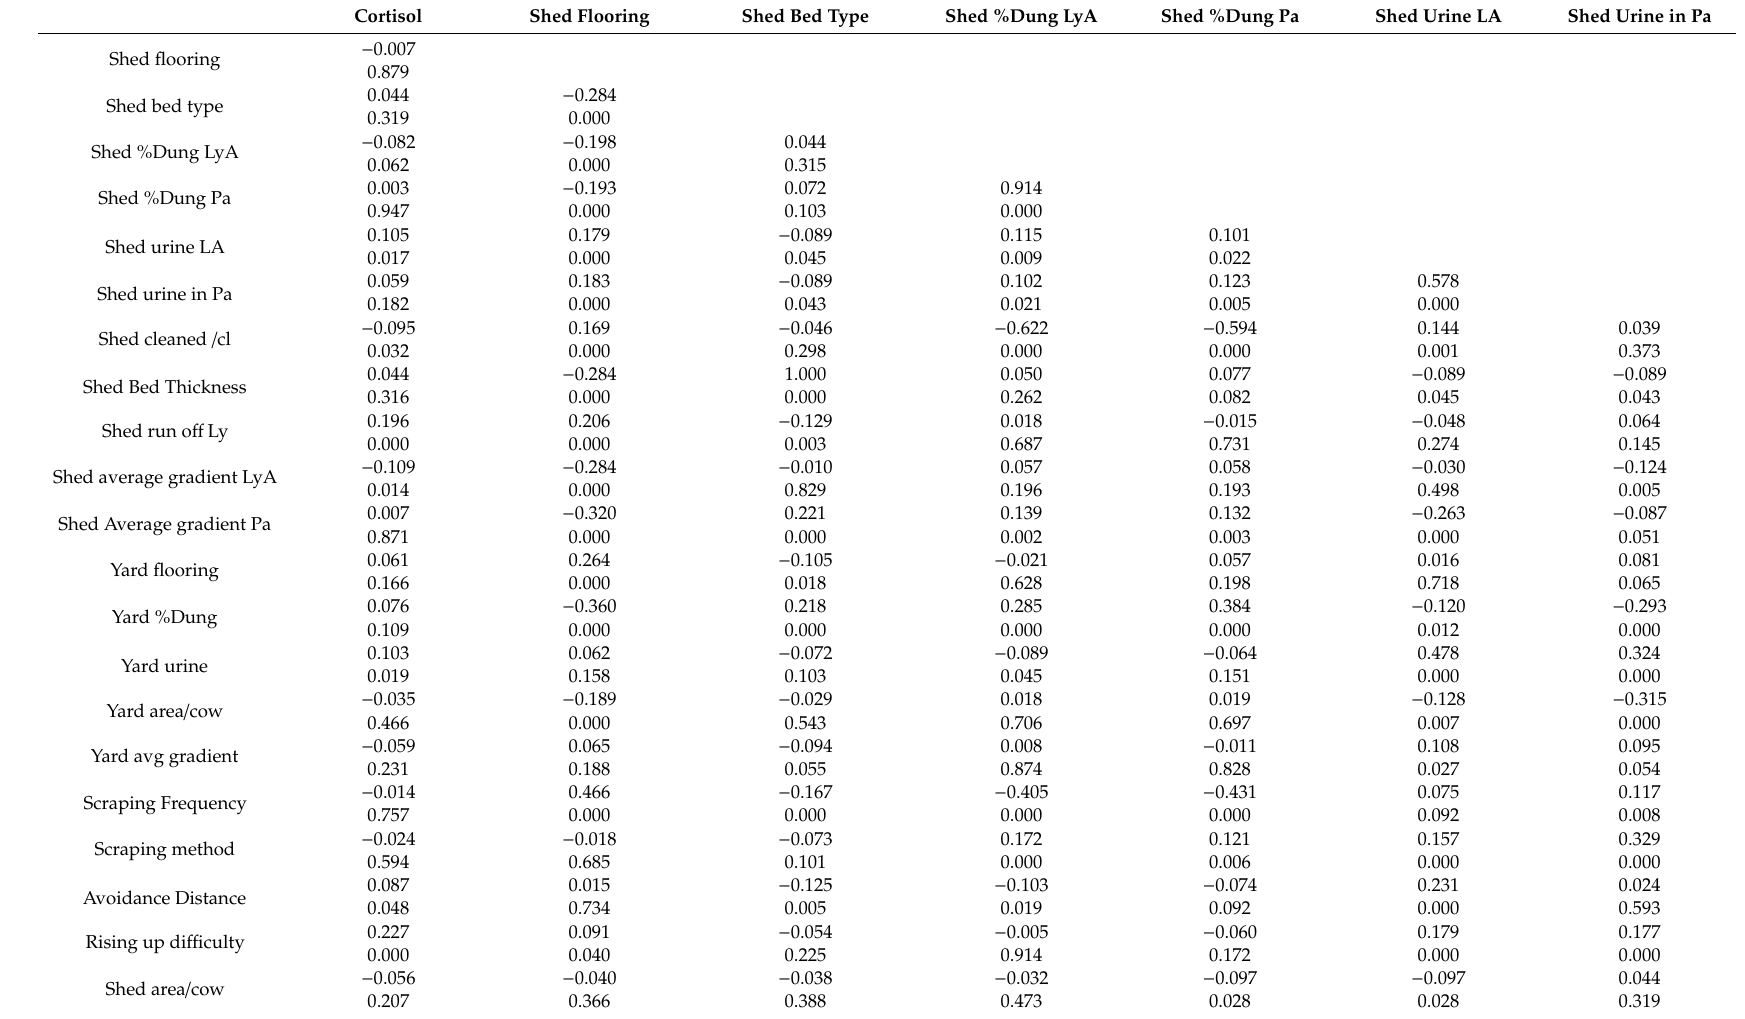
Table A3. Univariate correlations between variables in the resource-based